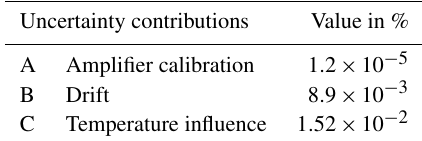
Table 2. Additional contributions to the measurement uncertainty of the